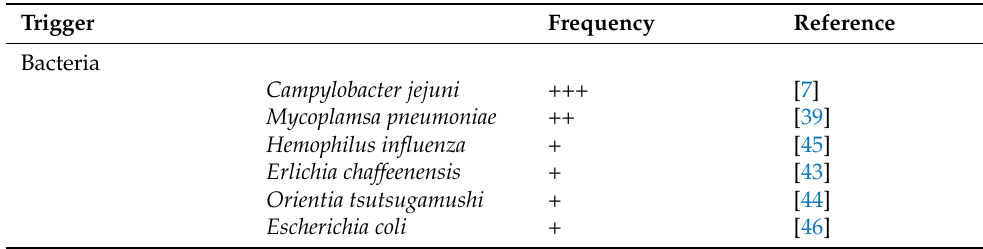
Table 1. Infectious agents, vaccinations, and other triggers of GBS reported in the